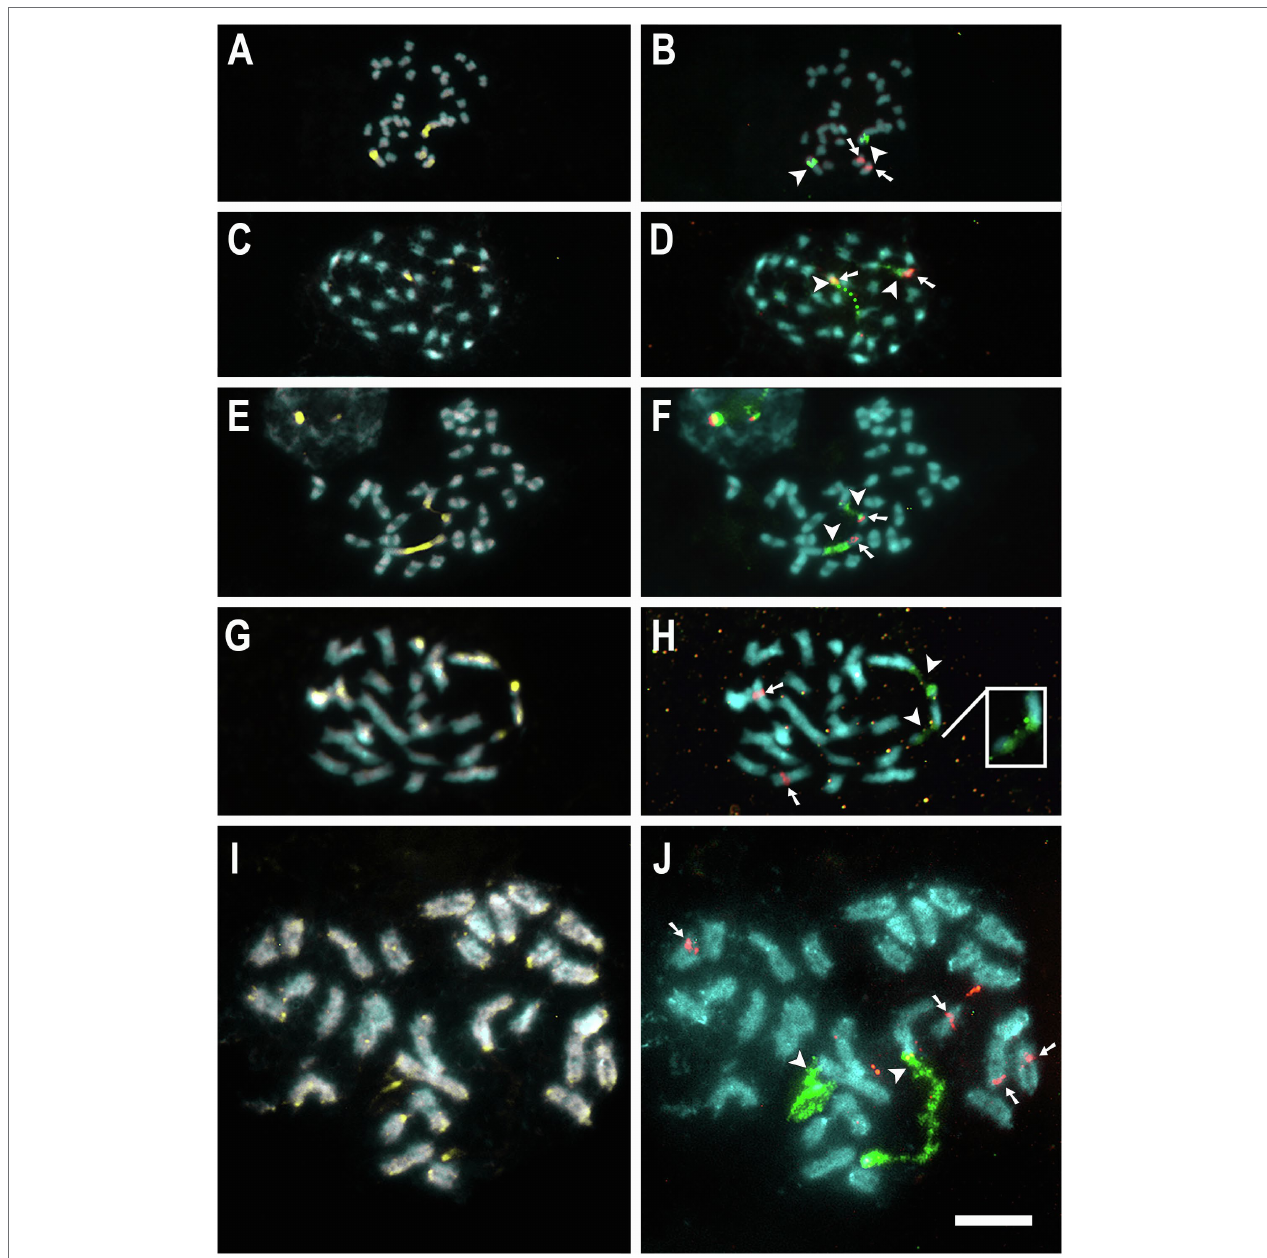
FIGURE 1 | Mitotic metaphases of diploids with karyotypes 2 n = 30. C. australis (A,B) , C. howelliana (C,D) , C. partita (E,F) , C. glomerata (G,H) , and C. epithymum (I,J) stained with CMA (yellow) and DAPI (blue) in A, C, E, G, and I , and with FISH of 5S (red) and 35S (green) rDNA in B, D, F, H, and J . Arrowheads indicate 35S (green) and arrows indicate 5S (red) rDNA sites. Insets show weak signals in higher contrast. Bar in J represents 10 μ m; all images at the same